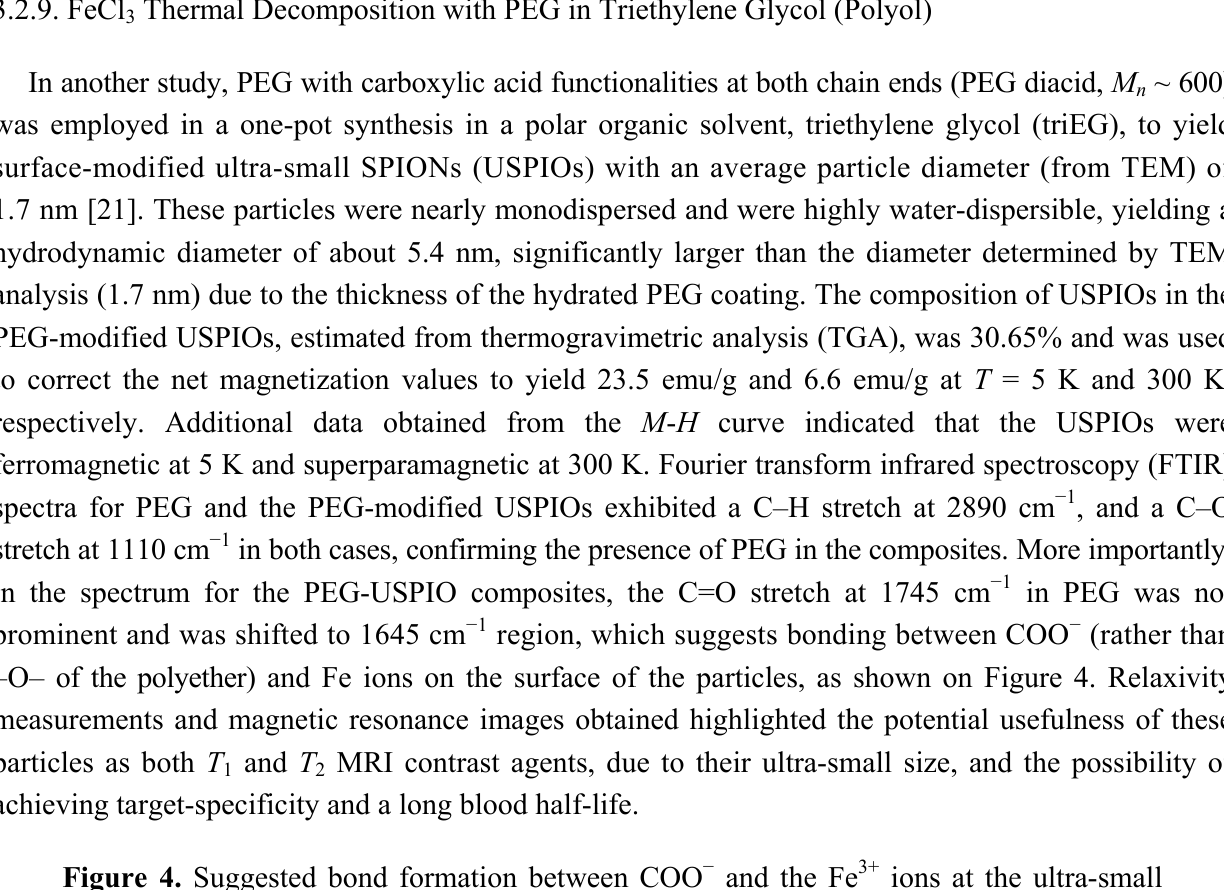
Figure 4. Suggested bond formation between COO − and the Fe 3+ ions at the ultra-small superparamagnetic iron oxide (USPIO) surface. Reprinted with permission from